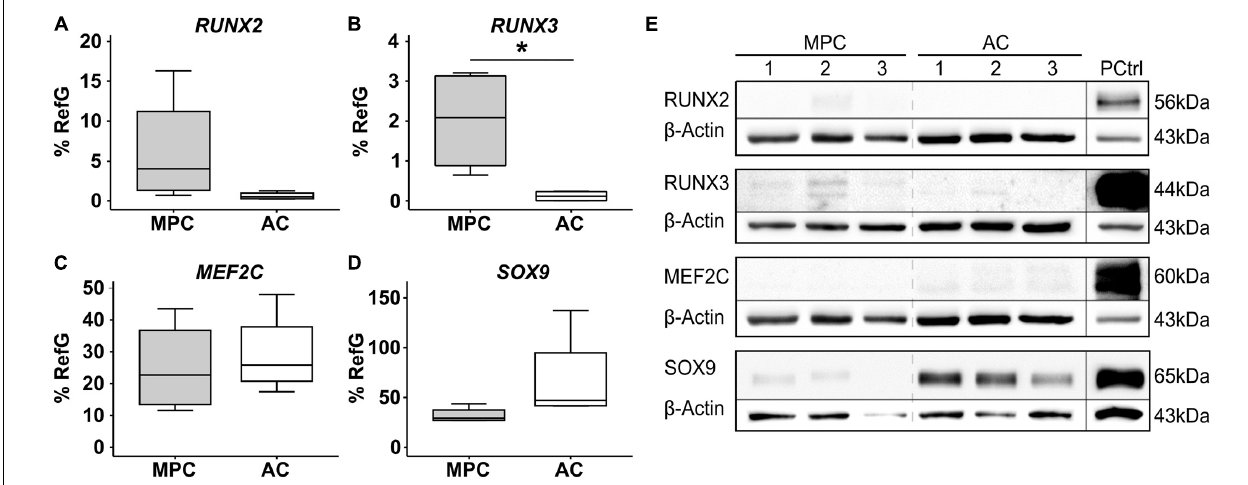
FIGURE 1 | Transcription factor signature of expanded MPCs. MPCs and ACs were harvested at passages 2–3 of expansion ( n = 4 donors). (A) RUNX2 , (B) RUNX3 , (C) MEF2C , and (D) SOX9 mRNA levels were determined by qPCR and levels were referred to reference genes HNRPH1 and CPSF6 . Data are shown as box plots, with each box representing the interquartile range (IQR) extending between the 25th and 75th percentiles, and lines inside the boxes representing the median. Whiskers extend to minimum and maximum values. *, p ≤ 0.05, Mann–Whitney U test. (E) RUNX2, RUNX3, MEF2C, and SOX9 protein levels were determined by Western blot analysis in cell lysates from three donors (MPC1-3, AC1-3) on the same gel, β -actin levels were determined as internal reference, and SAOS-2 cell lysate was used as positive control on the same gel